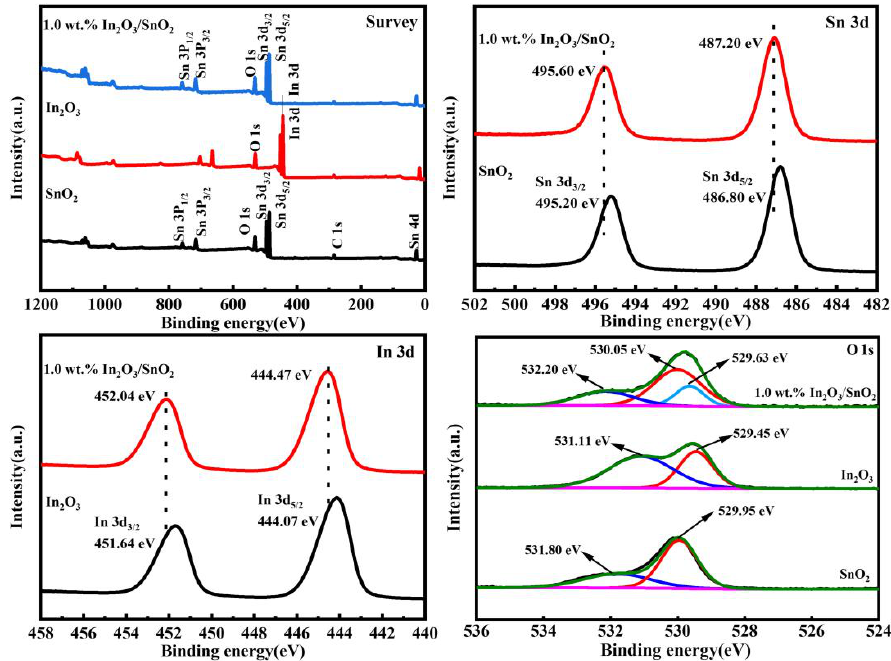
Figure 4. XPS spectra of pure SnO 2 , In 2 O 3 and 1.0 wt.% In 2 O 3 /SnO 2 composite photocatalysts: ( a ) survey; ( b ) Sn3d; ( c ) In3d; ( d ) O1s.